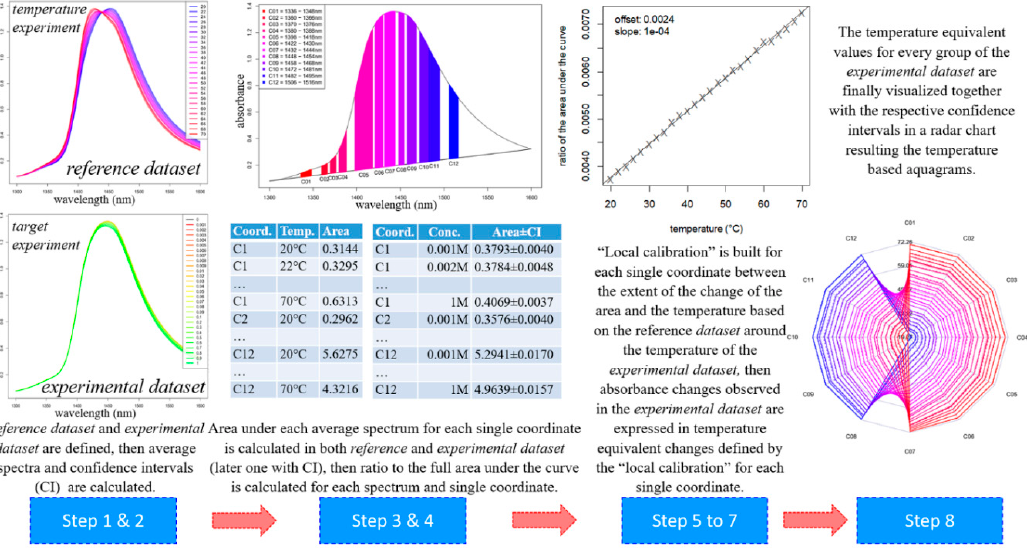
Figure A1. Workflow of the calculation protocol of temperature-based Figure B1. Workflow of the calculation protocol of temperature-based aquagram.